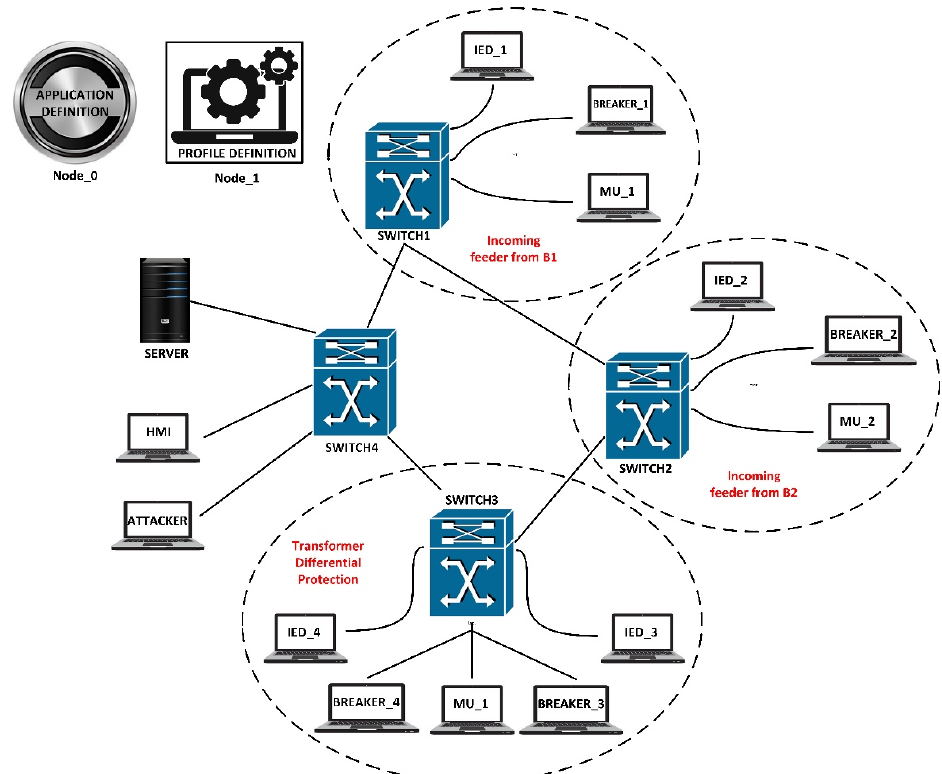
Figure 7. OPNET-based power grid substation layout.